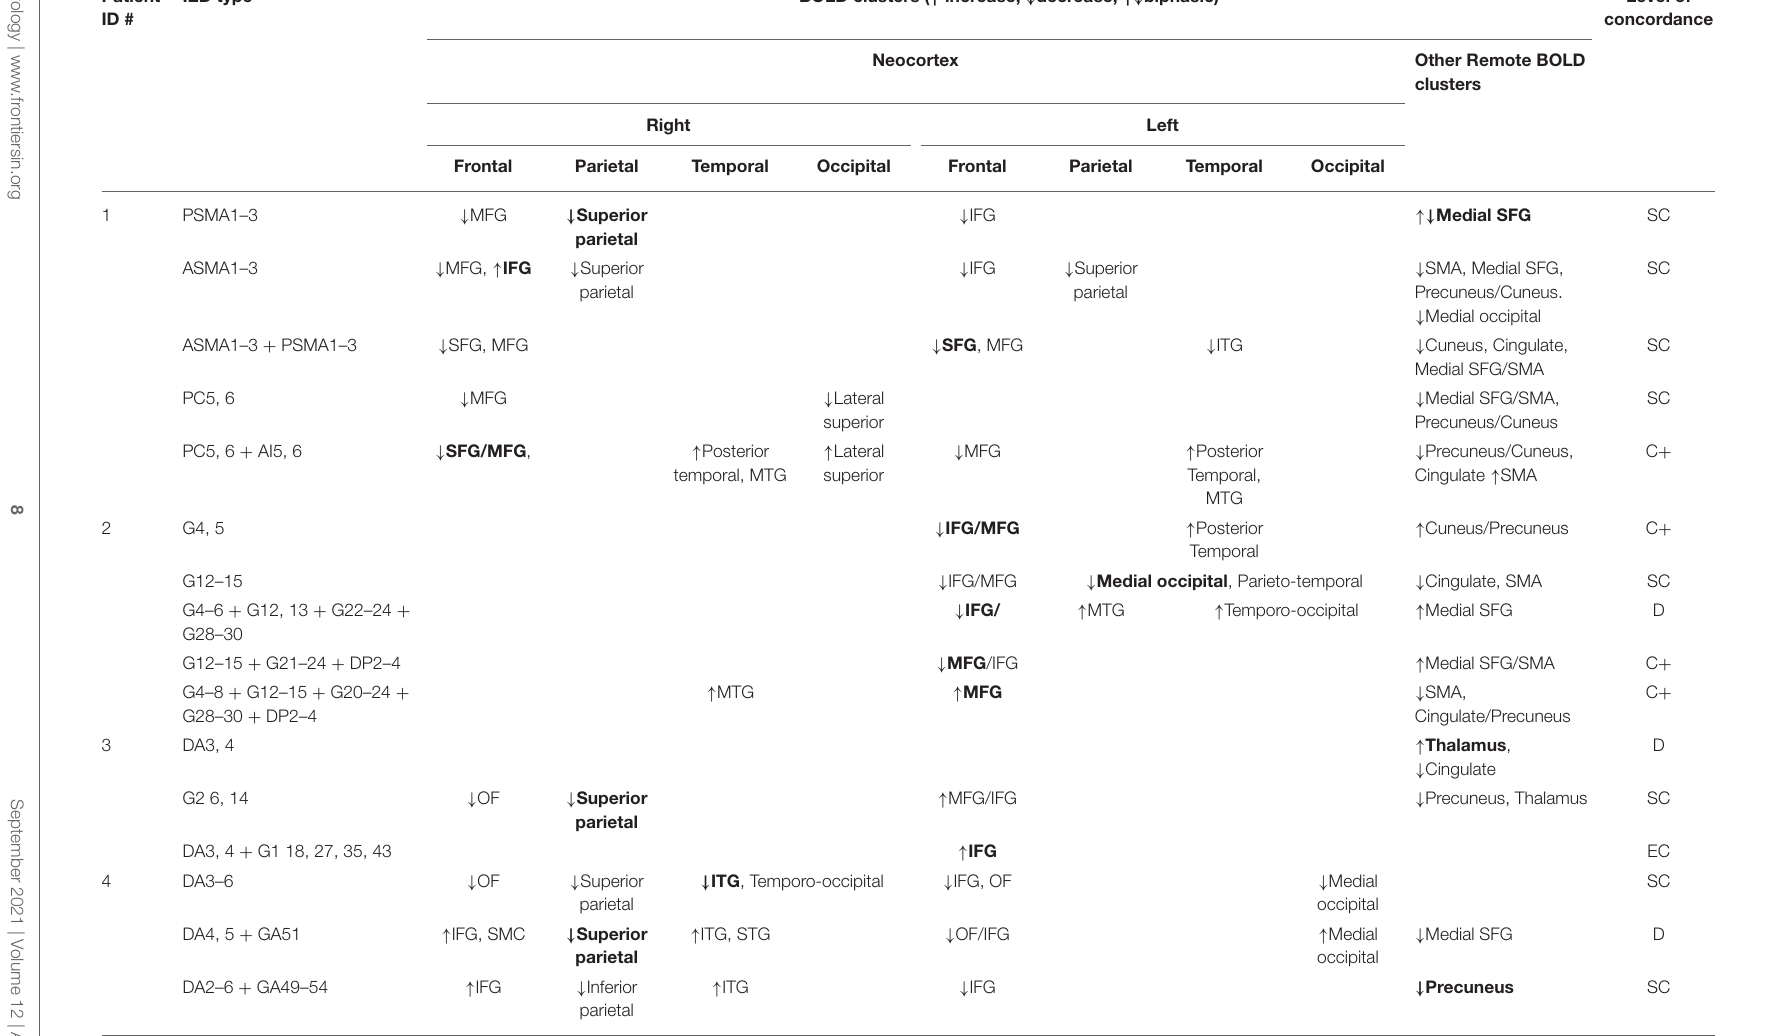
TABLE 3 | BOLD changes for individual IED